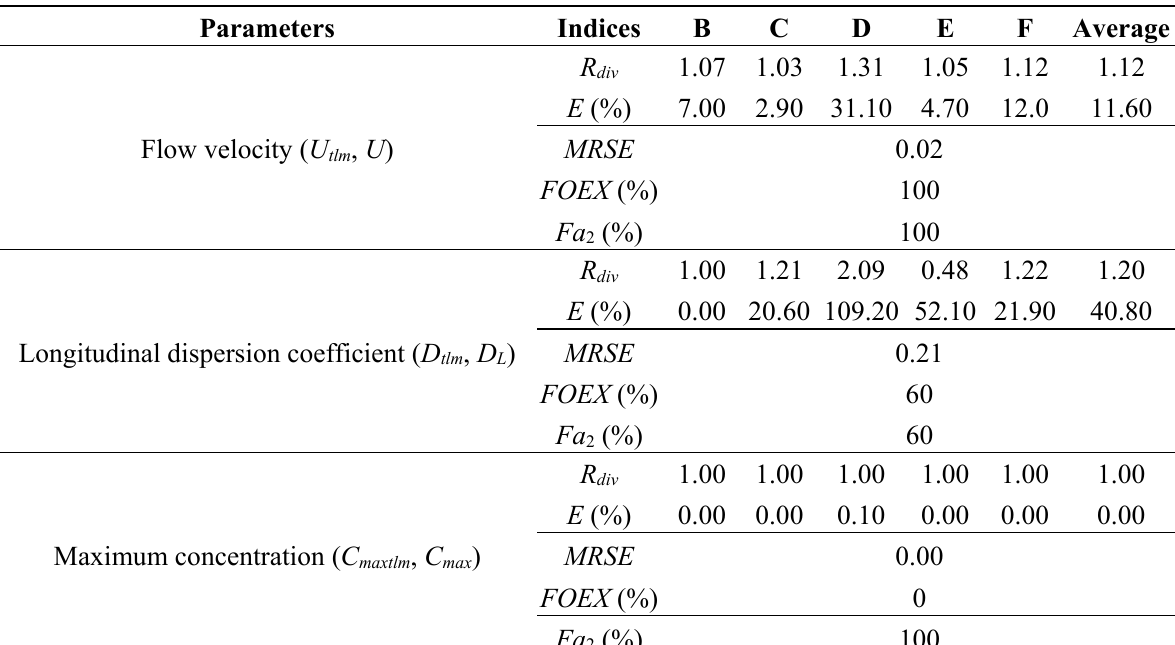
Table 5. Statistical tests for flow velocity, longitudinal dispersion coefficient and maximum